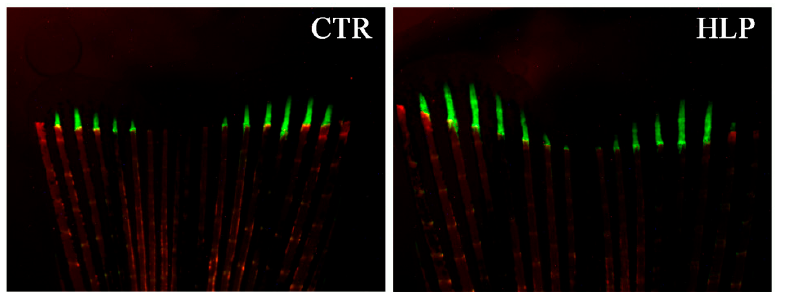
Figure 4. Calcein-alizarin double staining of fin rays: regenerated bone matrix in untreated (CTR) and treated with HI LFPEMFs (HLP) adult zebrafish fin (red staining highlights the old bone tissue and green staining highlights the new regenerated bone tissue).